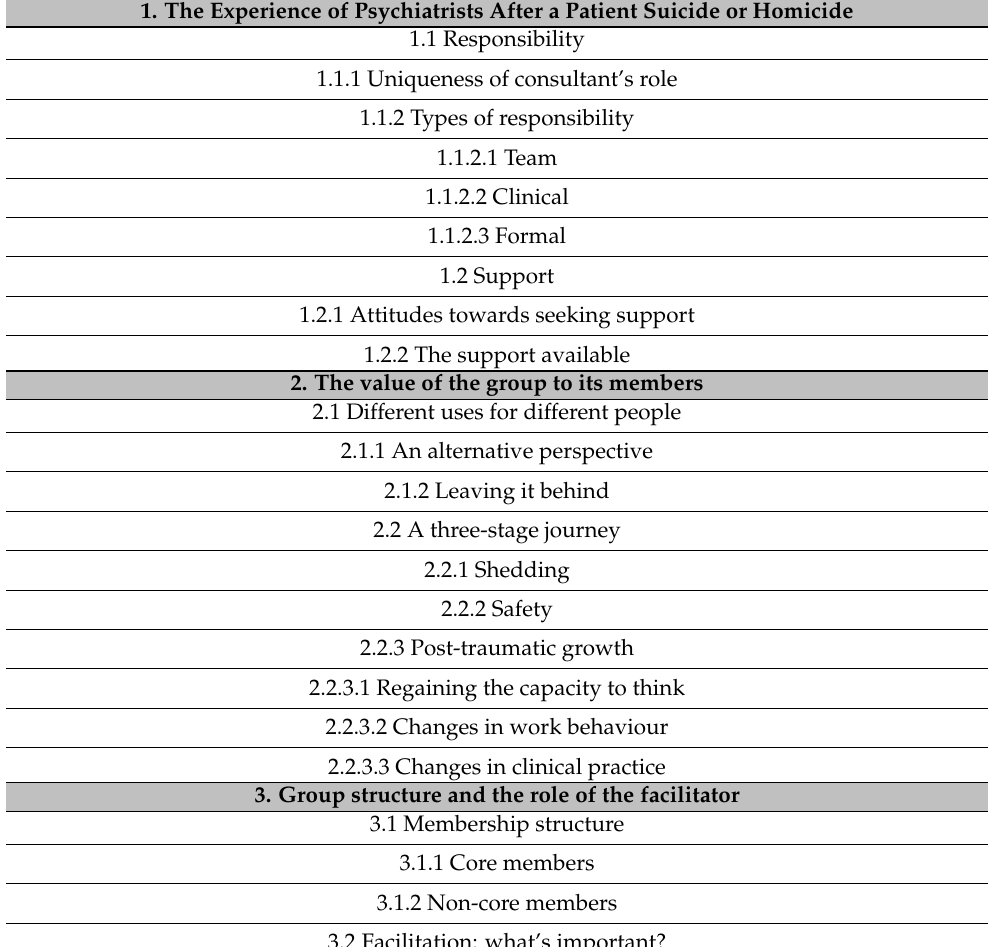
Table 2. Themes and sub-themes by research